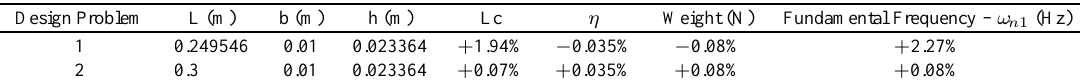
Table 4 Design optimization results, from response surface